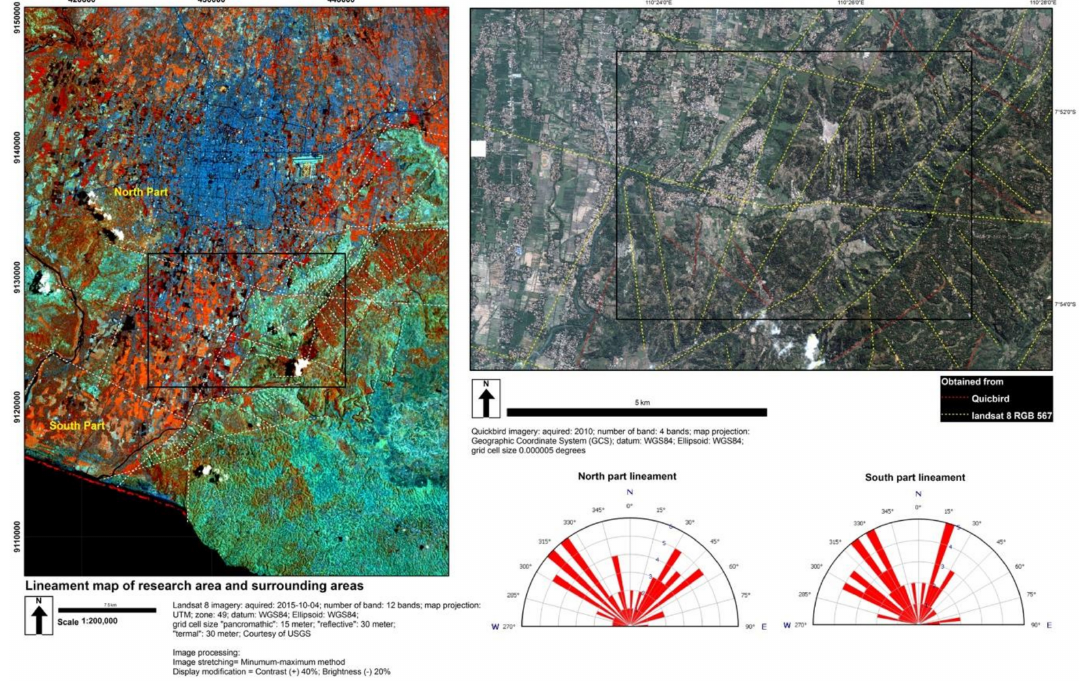
Figure 14. Lineament map of study